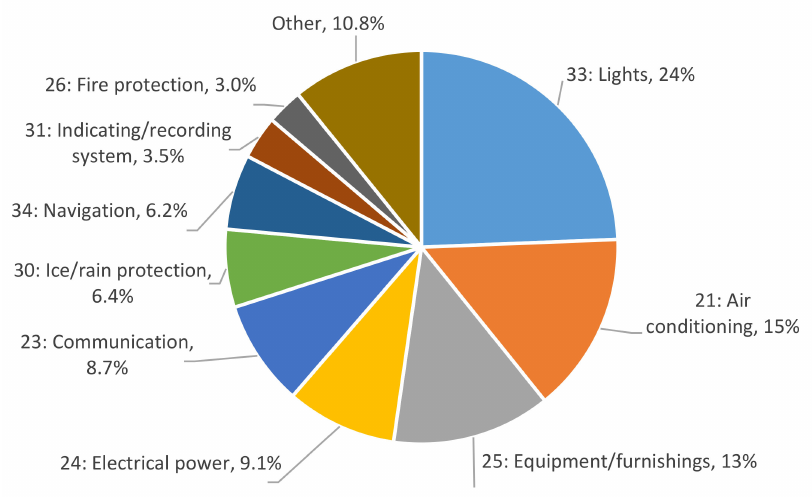
Figure 3. ATA chapters assigned by airlines to 4573 reports of electrical fumes/smoke.